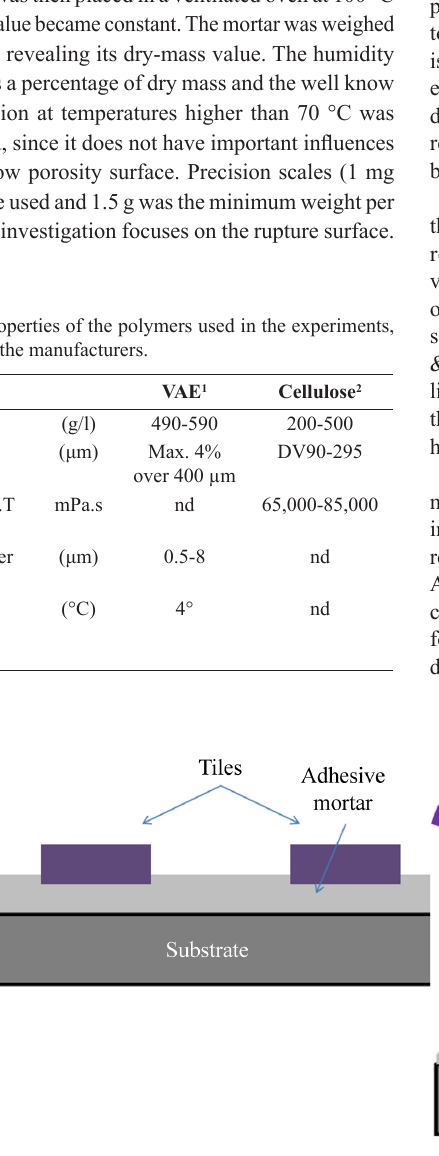
Figure 2. Method used to collect the damp mortar samples after the bond strength test.